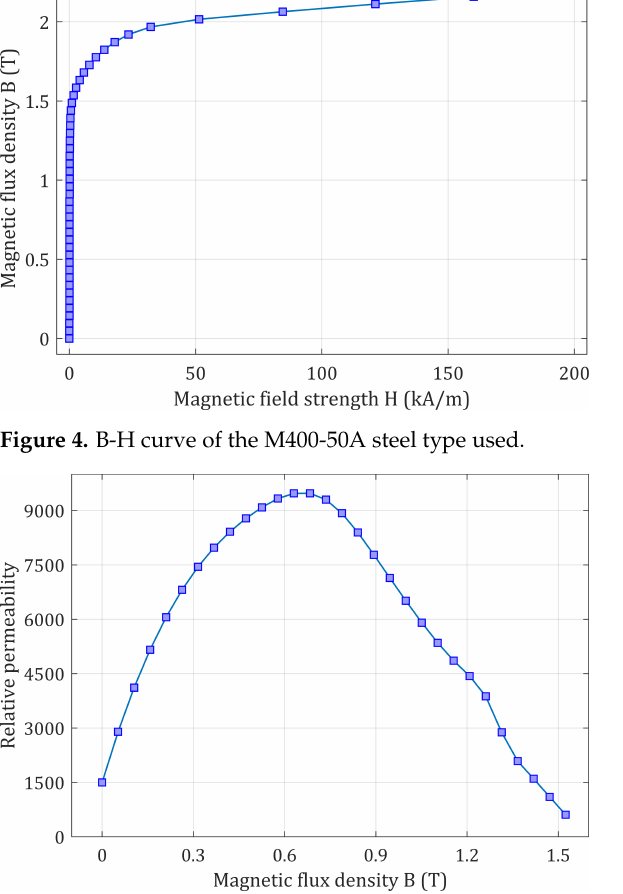
Figure 5. Relative permeability of the steel’s lamination sheet